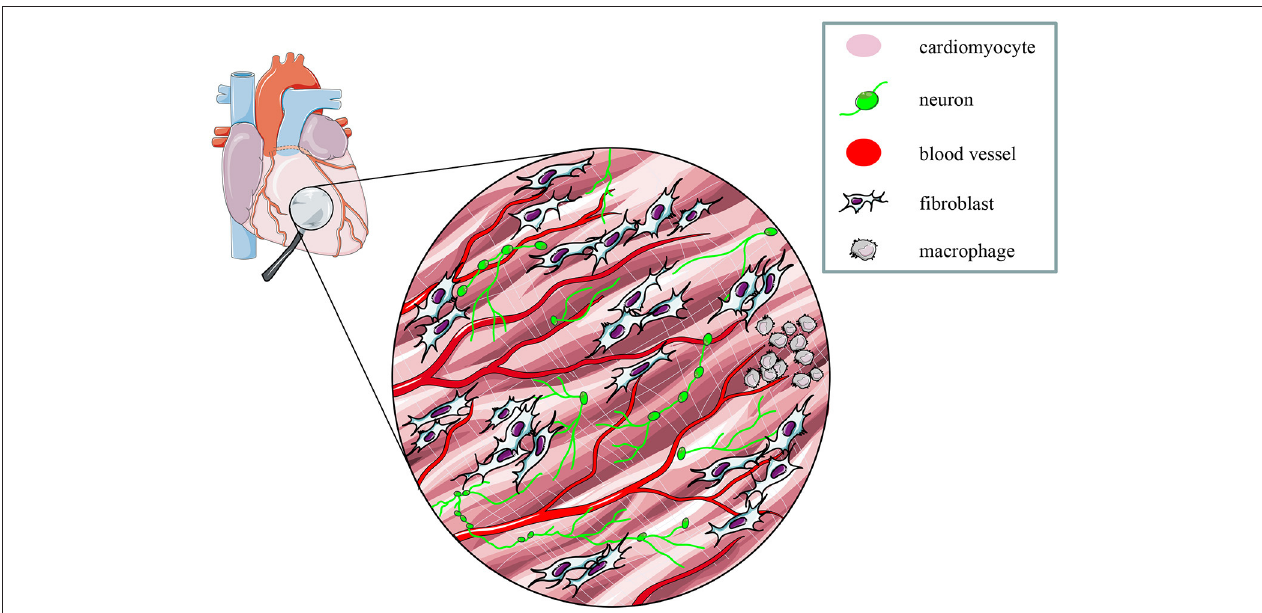
FIGURE 2 | The multicellular nature of the myocardium. The myocardium is a complex network of different structural and functional interconnected cell types, including intrinsic and extrinsic excitable, as well as non-excitable cells. Modified with permission from Zaglia et al.